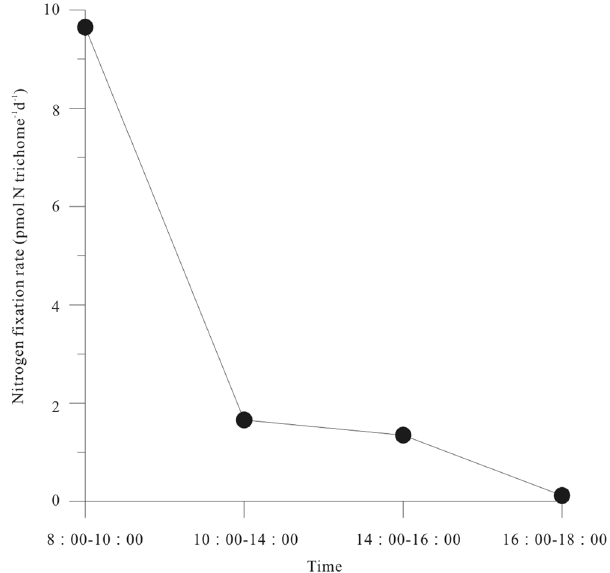
Figure 5. Daily variations of N 2 fixation rate by Trichodesmium at Sta. E404. Note for software: Origin 8.5 PRO (http://www.originlab.com/).